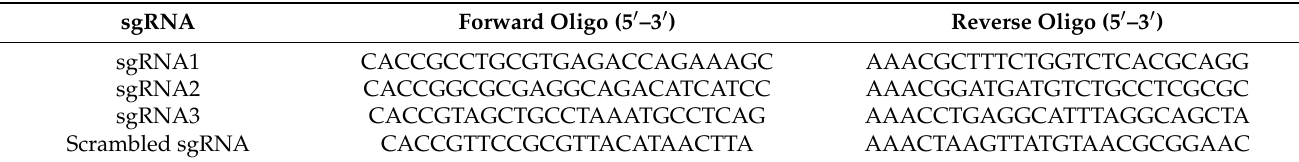
Table 2. The oligonucleotide sequences of the TLR4 sgRNAs and scrambled